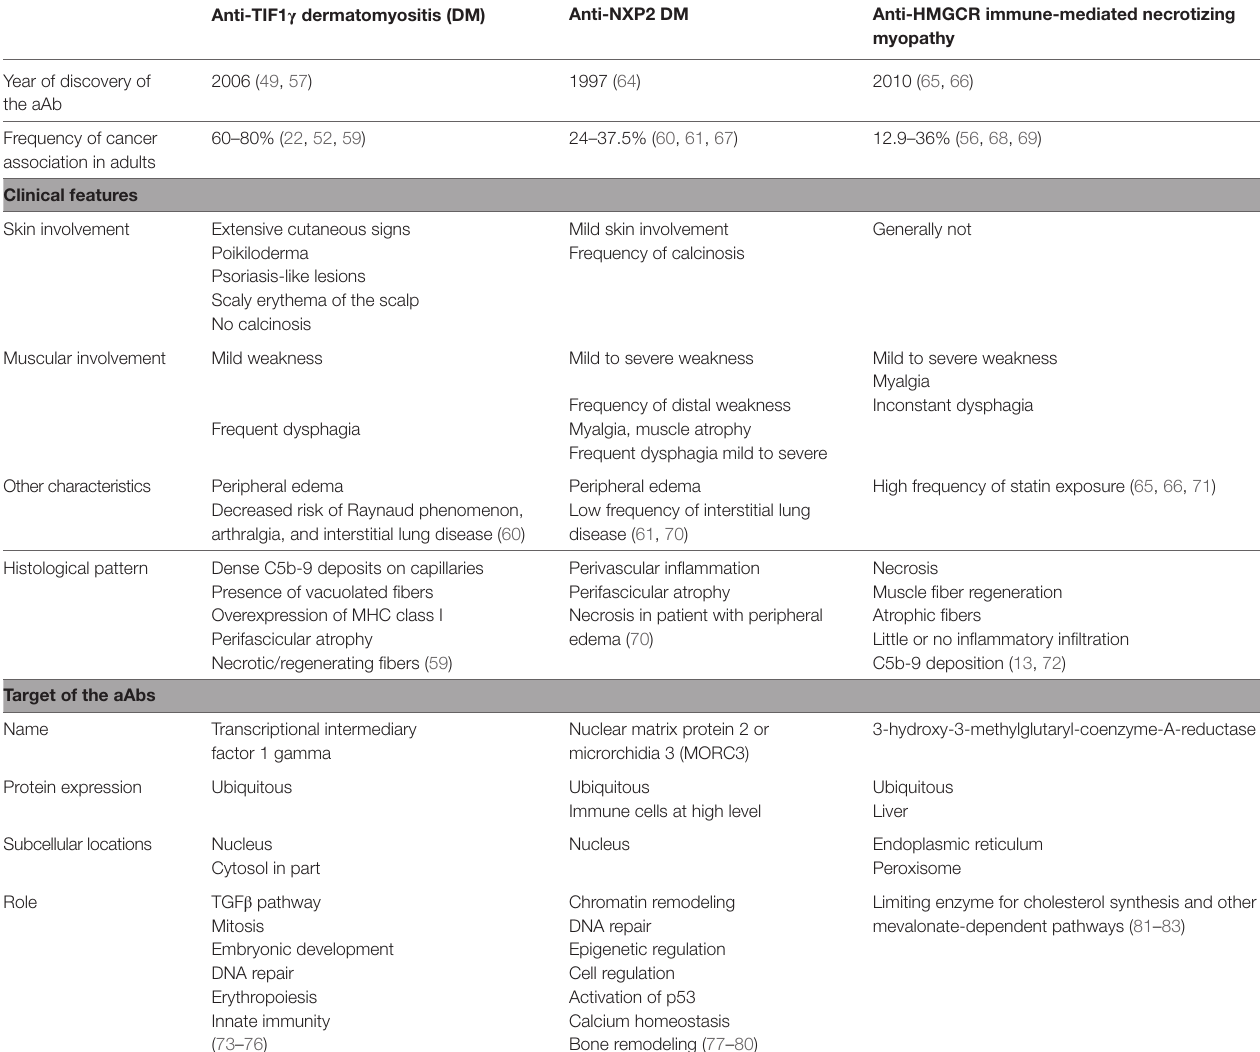
TABLe 1 | Characteristics of anti-TIF1 γ , anti-NXP2, and anti-HMGCR